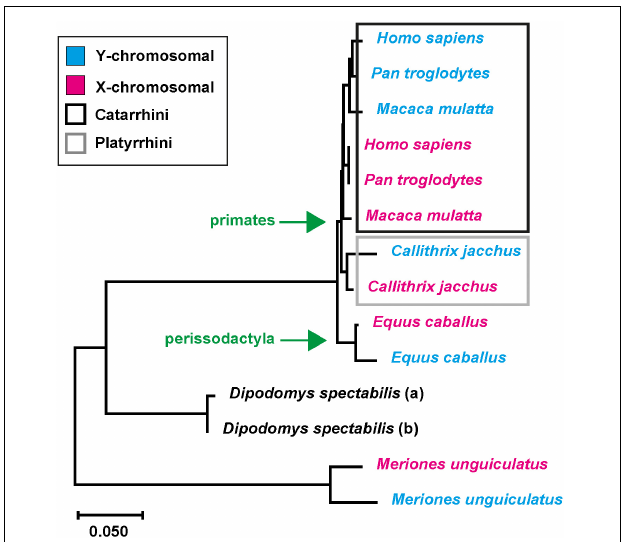
FIGURE 5 | Independent neuroligin-4 diversification into gametologs. Six pairs of NLGN4X and NLGN4Y coding sequences as well as a pair of neuroligin-4 sequences from D. spectabilis were used to infer the evolutionary history using the Neighbor-Joining method (Saitou and Nei, 1987). Depicted is the optimal tree with the sum of branch length ∼= 0.649. Statistics of bootstrap replicates can be found in Supplementary Figure 4 . The tree is drawn to scale. The evolutionary distances were computed using the Maximum Composite Likelihood method (Tamura et al., 2004) and are in the units of the number of base substitutions per site. The rate variation among sites was modeled with a gamma distribution (shape parameter = 1). The differences in the composition bias among sequences were considered in evolutionary comparisons (Tamura and Kumar, 2002). All ambiguous positions were removed for each sequence pair (pairwise deletion option). There were a total of 1,008 positions in the final dataset. Evolutionary analyses were conducted in MEGA X (Kumar et al., 2018; Stecher et al., 2020). Diversification in X- and Y-specific neuroligin-4 copies occurred at least twice and independently within primates and rodents, respectively, as well as in the evolution of horses in the order